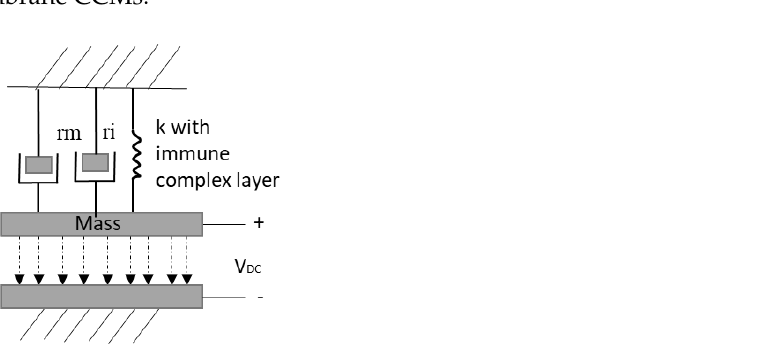
Figure 23. Circular capacitive micromachined ultrasonic transducer (CMUT) bilayer model.